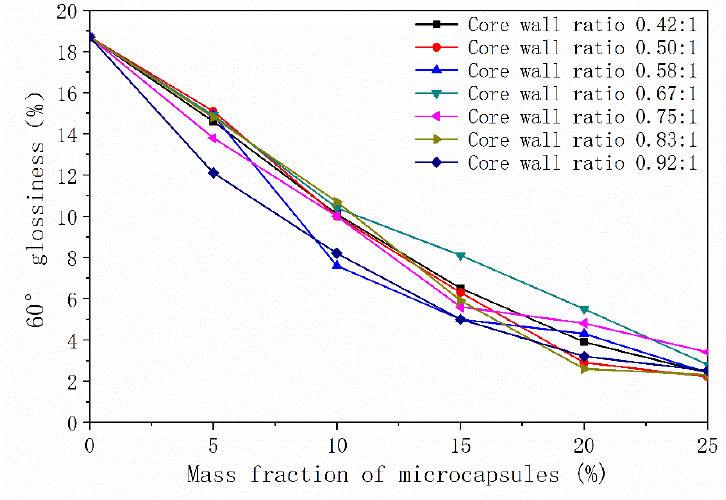
Figure 3. The glossiness of the coatings.